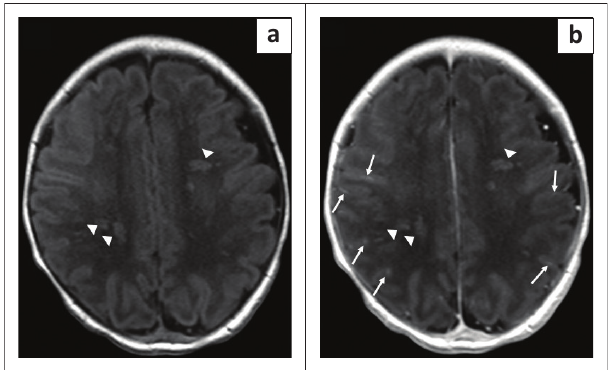
FIGURE 5: Axial T1-weighted MRI of the brain at the level of centrum semiovale (repetition time msec/echo time msec, 300/2.52, 3-mm section thickness), unenhanced (a) and contrast-enhanced (b) after intravenous injection of 1 mL of gadoteridol (ProHance; Bracco). There were areas of non-enhancing signal abnormality in the bilateral supratentorial frontal white matter (solid white arrow heads on images [a] and [b]), corresponding to the restricted diffusion. Subtle leptomeningeal contrast enhancement seen (solid white arrows on image